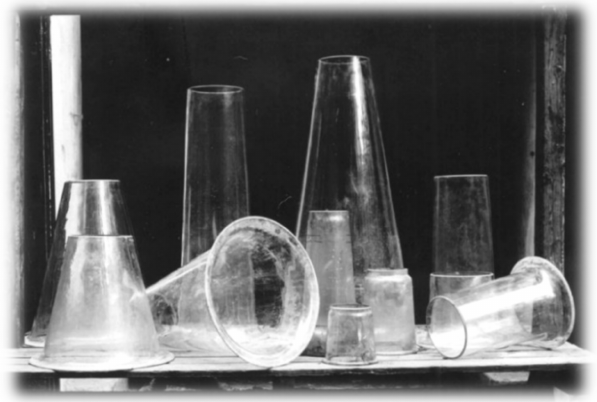
Figure 11. Glass draft tubes used in the experiments. Source: [5].